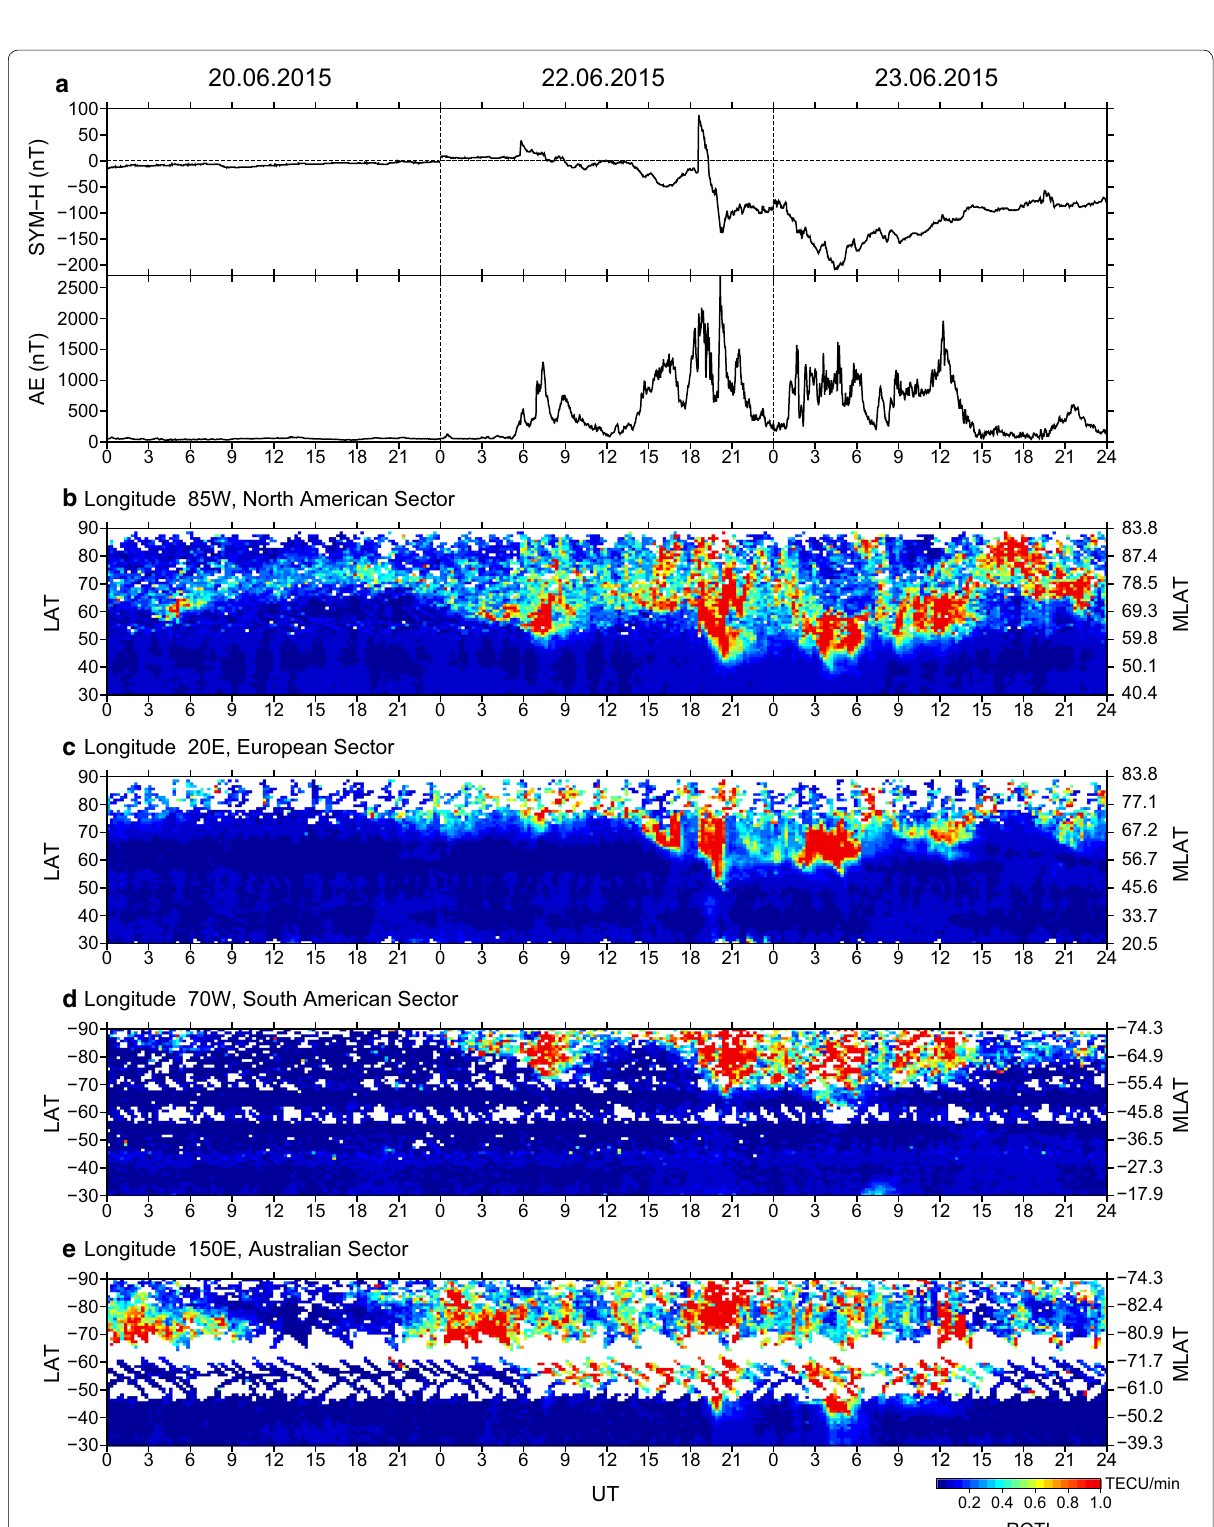
Fig. 6 Comparison of a the SYM-H and AE indices with 1 min resolution and ROTI perturbations with 15 min resolution as a function of geographic latitude and time, evaluated along b 85W in North America, c 20E in Europe, d 70W in South America and e 150E in the Australian sector during June 20 and June 22–23, 2015. The left vertical axis for b – e graphs shows geographic latitudes, right axis —the corresponding corrected geomag- netic